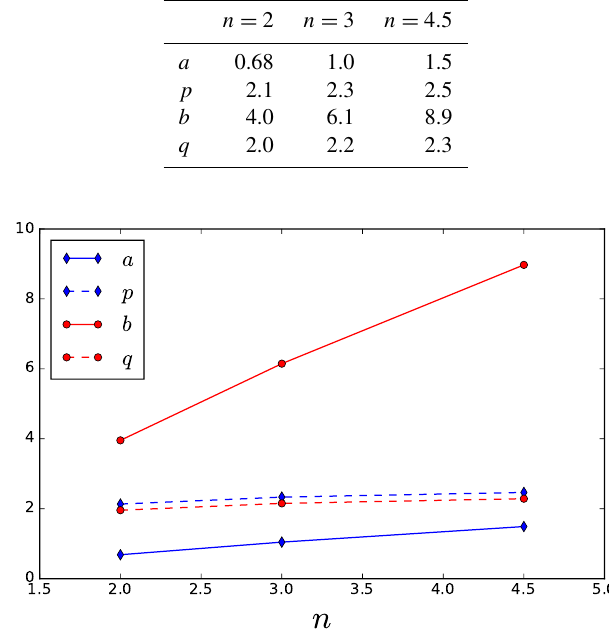
Figure 7. Evolution of the fitted coefficients a , p , b and q with re- spect to the exponent n of the Norton Hoff ice constitutive behavior.